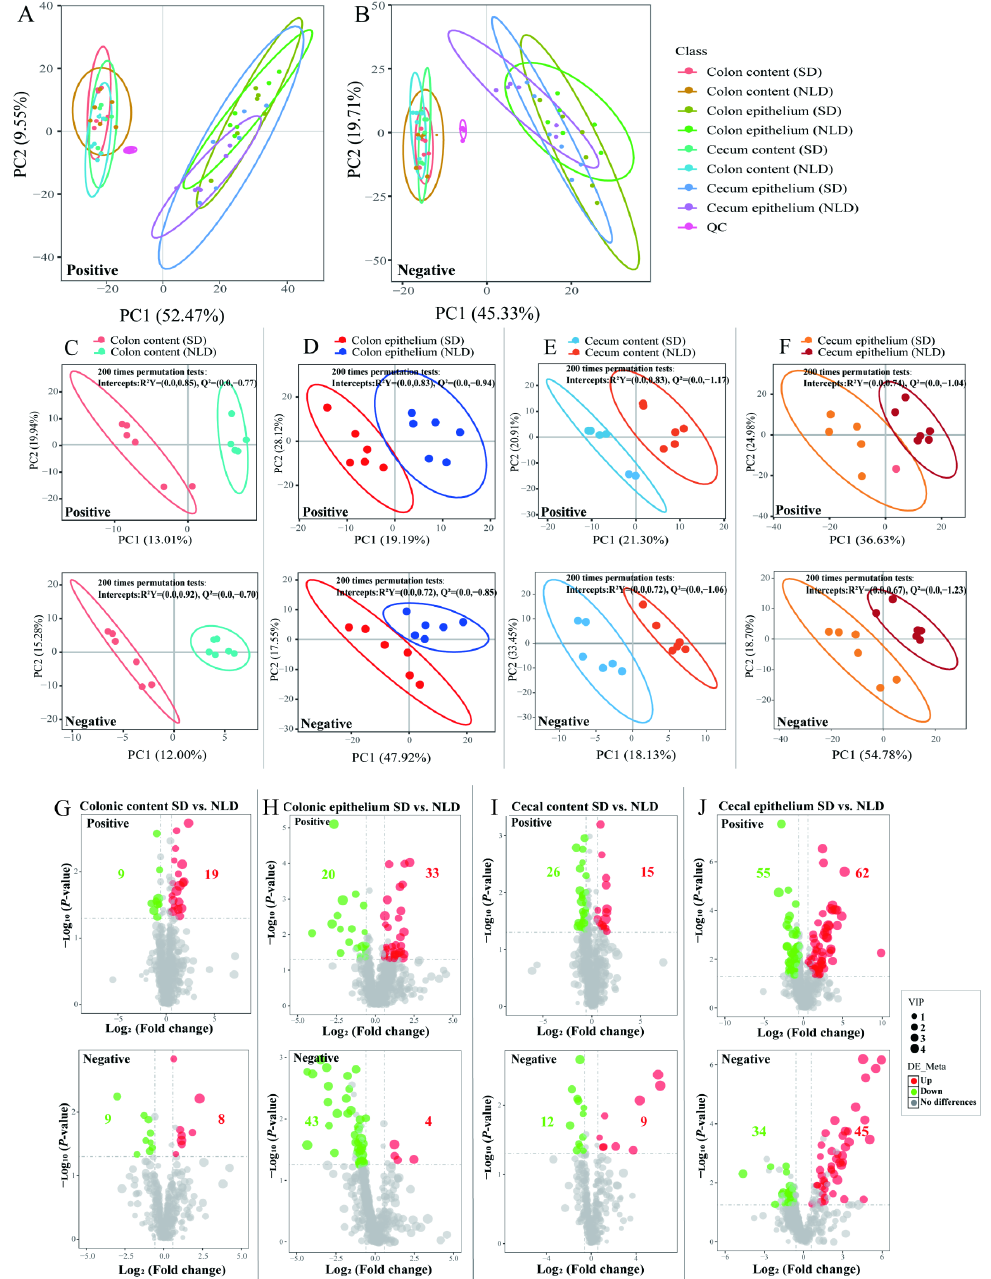
Figure 5. Overview of metabolomics profiles and the volcano plots of significantly different metabolites of colonic and cecal contents and epithelium in ABX mice under NLD and SD. NLD, the antibiotic-treated mice managed under normal light–dark cycle; SD, the antibiotic-treated mice managed under short-day cycle; QC, quality control group. The PCA plot based on LC/MS analysis in ABX mice under NLD and SD among different groups in positive ion mode ( A ) and negative ion mode ( B ) are shown. The PLS-DA plot based on LC/MS analysis and its corresponding validation plots based on 200 times permutation tests in colonic contents ( C ), colonic epithelium ( D ), cecal contents ( E ), and cecal epithelium ( F ) in ABX mice under NLD and SD are shown in both positive and negative ion modes. Volcano plots of differential metabolites in colonic contents ( G ), colonic epithelium ( H ), cecal contents ( I ), and cecal epithelium ( J ) in both positive and negative ion modes are shown in ABX mice under NLD and SD. Red dots represent increased, blue dots represent decreased, and the gray dots represent did not change significantly; numbers represent the number of significant different